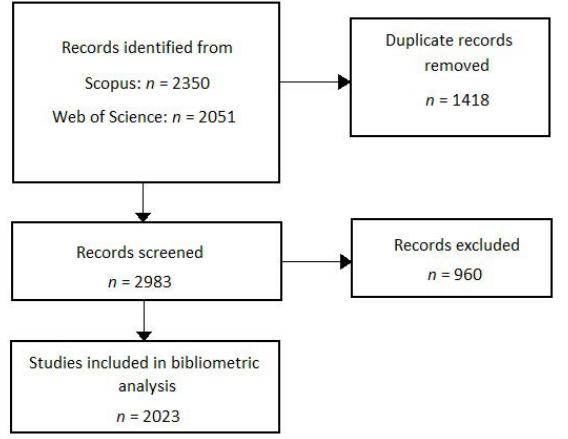
Figure 1. Flow chart diagram of the study search and selection